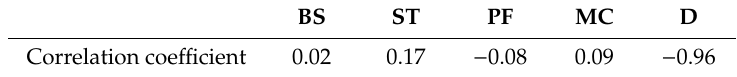
Table 6. Correlation sensitivity analysis (CSA) for PPV results in MC simulation.